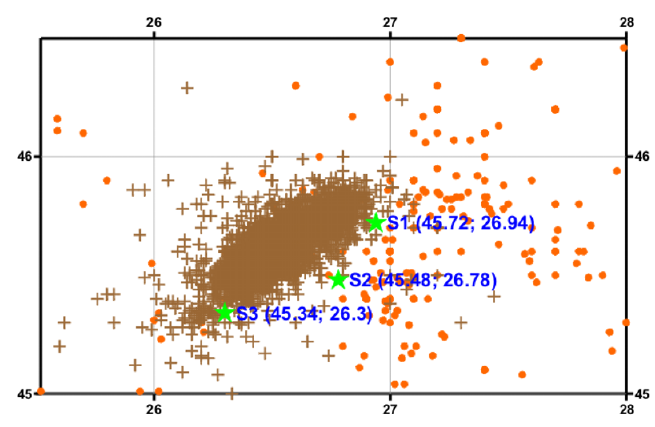
Figure 1 (above). Seismicity of Romania from 984 to 2011, for M Brown crosses, subcrustal earthquakes; orange dots, crustal earthquakes [from Romplus catalog 2011]. Figure 2 (below). Seismicity of the Vrancea zone. The stars correspond to the epicenters of the three shocks of 1977. The area corresponds to that indicated in Figure